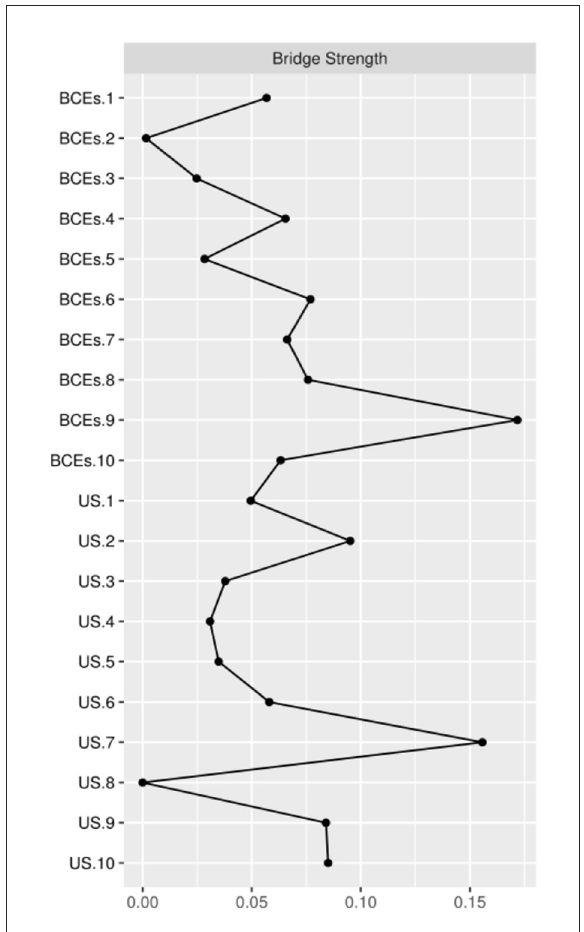
FIGURE5 Bridge centrality indices of the BCEs-uncertainty stress network among Chinese university